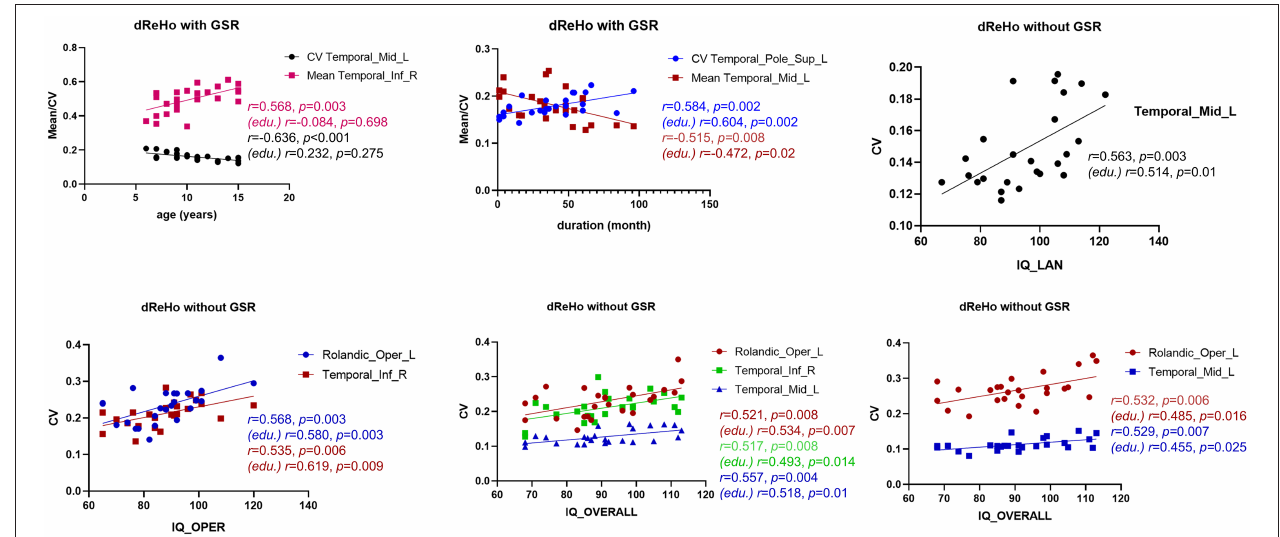
FIGURE 5 | Association analyses. With global signal regression (GSR), the CV of dReHo in the left middle temporal gyrus (MTG.R) was positively associated with age, and a negative correlation was revealed between the mean dReHo of the MTG.R and duration. Besides, a significantly negative association was found between the mean dReHo of the right inferior temporal gyrus (ITG.R) and age, and the CV of dReHo in the left temporal pole (TPO.L) was positively related to disease duration. Without GSR, the CV of dReHo in MTG.L was positively correlated to IQ_LAN and IQ_OVERALL scores in children with BECTS. In addition, the CV of dReHo in the left Rolandic operculum (ROL.L) and ITG.R were both positively associated with IQ_OPER and IQ_OVERALL scores. Results with age regression are also marked